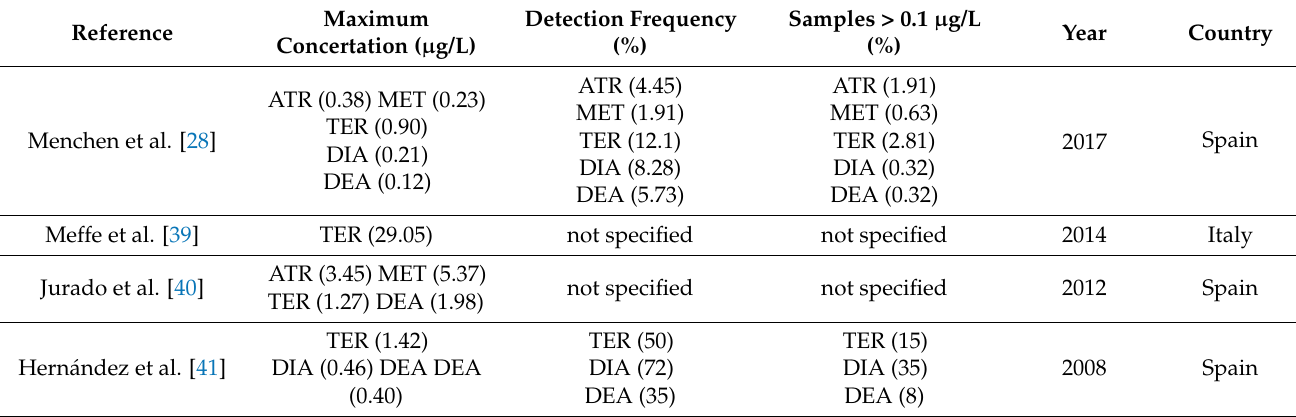
Table 4. Pesticides concentration from different European